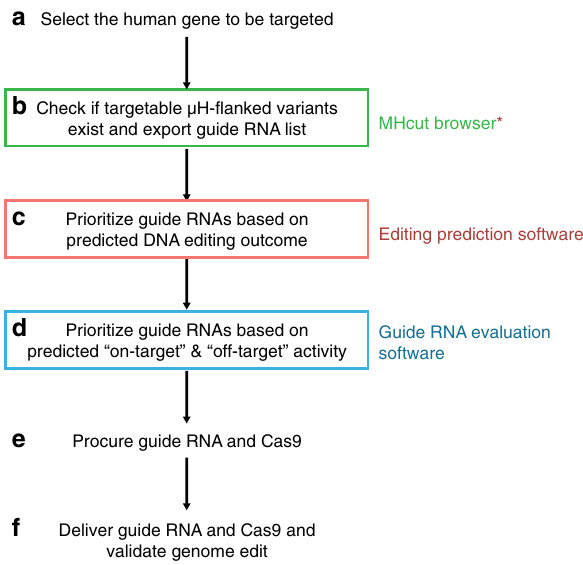
Fig. 5 MHcut tool complements existing tools for selecting a suitable gene editing target and gRNA. (*MHcut tool contains the editing prediction for the target deletion from the inDelphi editing outcome prediction tool 14